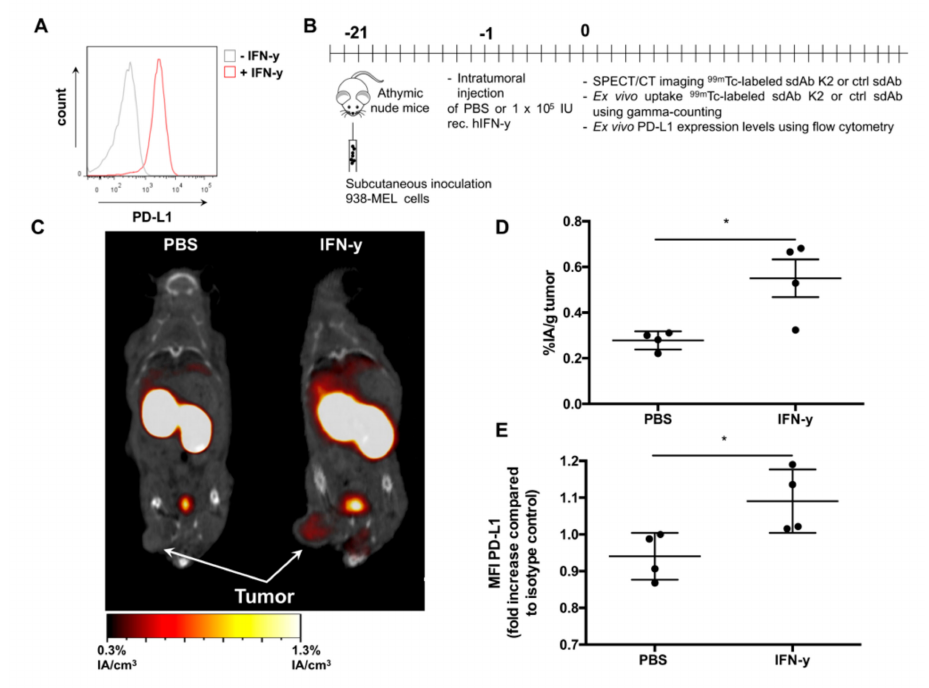
Figure 5. Radiolabeled sdAb K2 allows specific visualization of human PD-L1 induced by IFN- γ in 938-MEL tumors. ( A ) Representative histogram showing PD-L1 expression after in vitro stimulation of 938-MEL cells with 100 IU / mL recombinant human IFN- γ (red) or non-treated 938-MEL cells